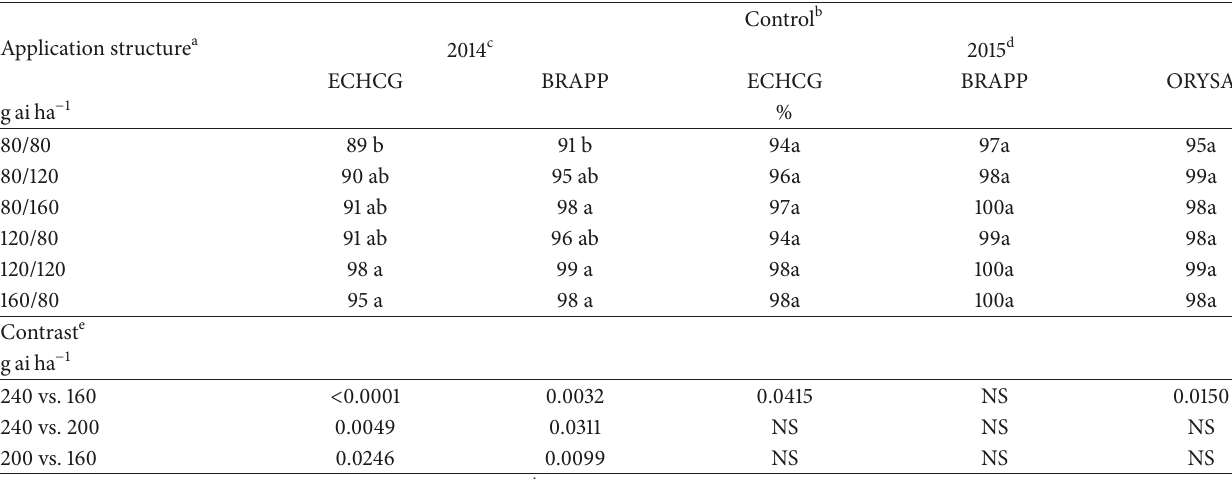
Table 3: Effect of quizalofop application structure on barnyardgrass, broadleaf signalgrass, and red rice control at Stuttgart, AR, in 2014 and 2015 averaged over time of first application followed by contrast between total quizalofop usage rates.